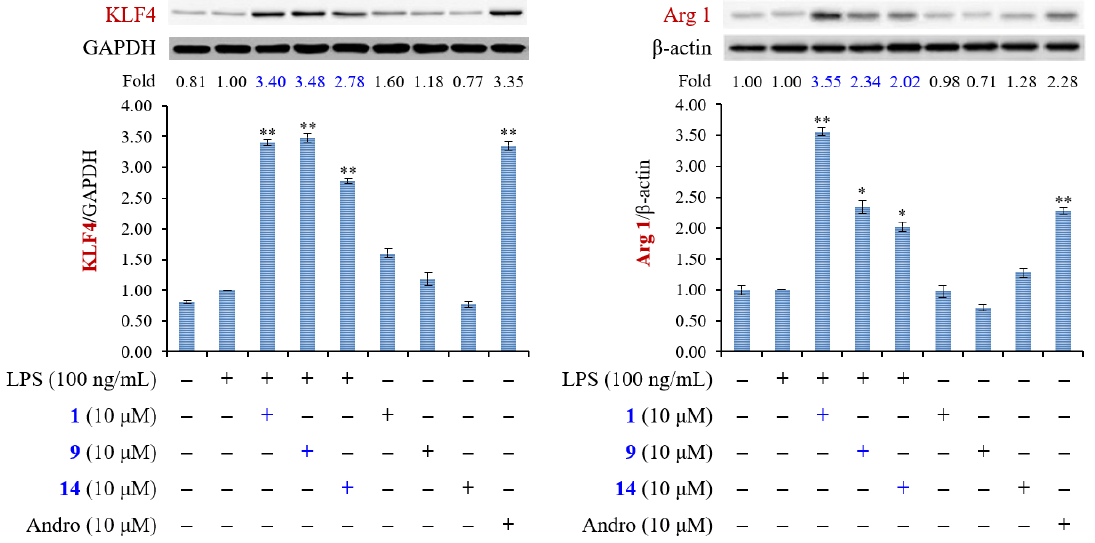
Figure 7. The effect of compounds 1 , 9 , and 14 on M2 polarized macrophages in LPS-stimulated RAW264.7 macrophages. RAW264.7 cells were pretreated with 1 , 9 , and 14 (10 μM) for 6 h, and then stimulated with LPS for 20 h. Expression of KLF4 and arginase 1 (Arg 1) were determined by Western blot analysis. Andrographolide (Andro) was used as positive control. The data were expressed as mean ± SEM of three independent experiments. “+” means treatment with LPS or compound. “−” means no treatment with LPS or compound. Asterisks indicate significant differences (* p < 0.05 and ** p < 0.01) compared with the control.